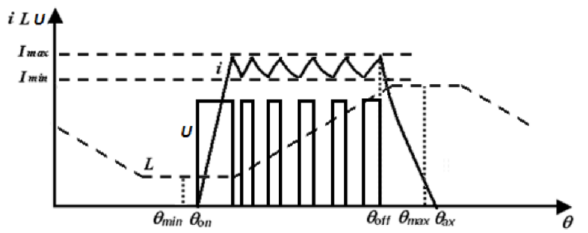
Figure 10. Current control. The waveform of current i , voltage U (PWM), and Phase inductance L of the SRM motor as a function of the position of the angle of the rotor poles in relation to the stator poles φ [30].